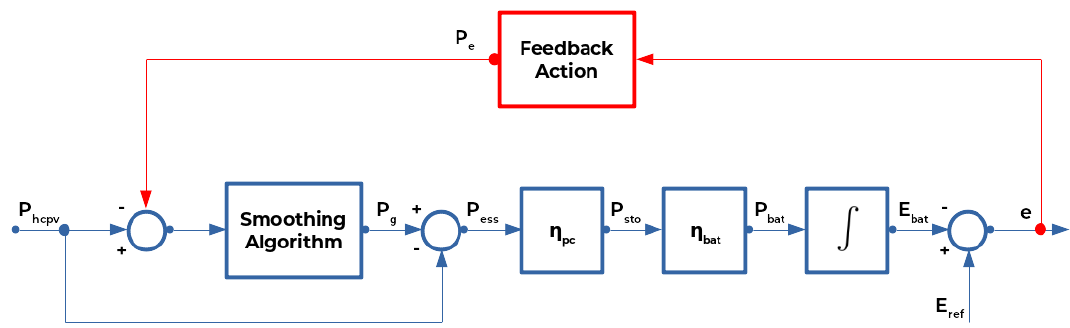
Figure 5. Generic block scheme of a smoothing algorithm. The branch associated with the optional feedback is in